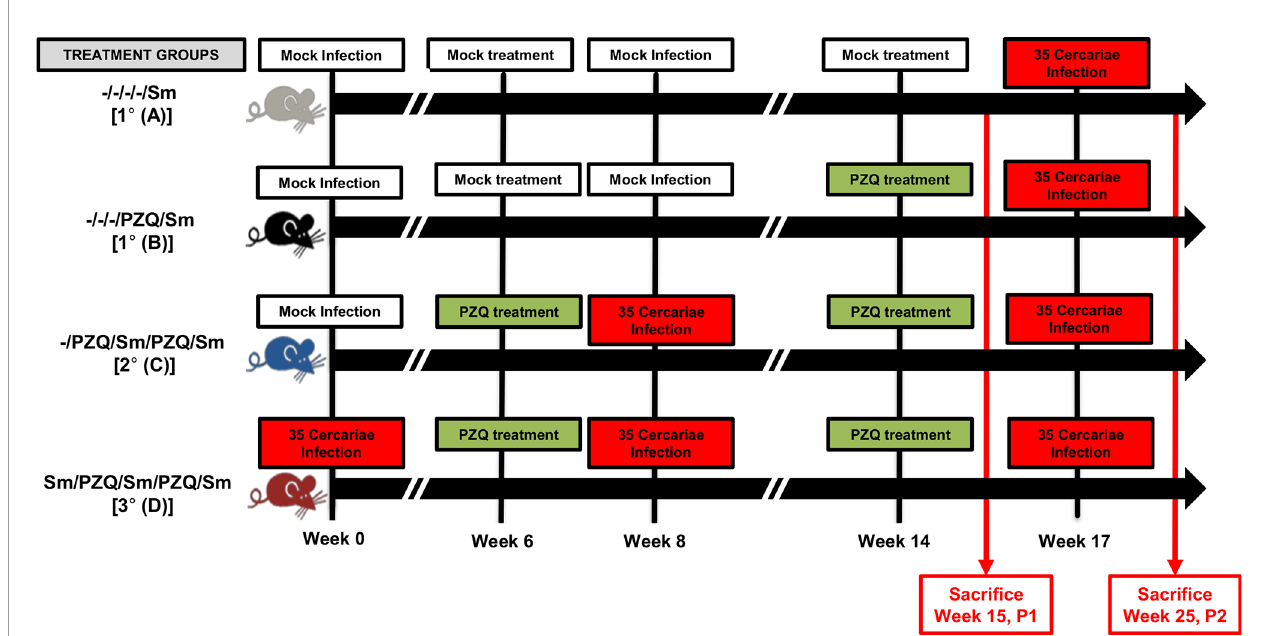
FIGURE 1 | Adjusted study design. Following experimental infection of mice with S. mansoni cercariae and anti-parasitic treatment with racemic Praziquantel (PZQ), the susceptibility to reinfection with S. mansoni and schistosomiasis-driven pathology was assessed. Brie fl y, C57BL/6 wild-type and immunocompetent mice (8-10 weeks old to ensure the use of adult mice only) of 20-30g were separated into four experimental groups omitting long term infections without interspersed episodes of PZQ treatments i.e. groups A, B, C and D. Group A for an overall total of 1 infection and no PZQ treatment i.e. -/-/-/-/Sm, group B with a single pretreatment with PZQ and an overall total of 1 infection i.e. -/-/-/PZQ/Sm; group C for a single pretreatment with PZQ, an overall total of two infections intercalated by another treatment with PZQ i.e. -/PZQ/Sm/PZQ/Sm; group D for an overall total of three infections intercalated by two PZQ treatments i.e. Sm/PZQ/Sm/PZQ/Sm, as indicated on the illustration. Practically, mice were infected percutaneously with 35 S. mansoni cercariae (or cercariae water as Mock) and treated 6 weeks later with racemic PZQ (or carrier solution) by administration at 400mg/kg twice by oral gavage. One week following the end of anti-parasitic treatment with PZQ, mice were reinfected percutaneously with 35 S. mansoni cercariae (or cercariae water as Mock) i.e. at week 8. Animals were then treated with racemic PZQ (or carrier solution) 6 weeks later i.e. at week 14 by daily oral administration of PZQ at 400mg/kg by oral gavage for 7 days. Two weeks after the end of this second round of anti-parasitic treatment i.e. at week 17, all mice, including controls from group A and B, were reinfected percutaneously, with 35 S. mansoni cercariae. Animals were sacri fi ced in part at week 15 p.i. (time point 1 i.e. P1) or week 25 (time point 2, i.e. P2) for assessment of parasitological, immunological and pathological changes between groups. Speci fi cally, biopsies of spleen, liver and blood were done for laboratory analyses of egg burdens, Antibody ELISA, Cytokine ELISA, Histology and Flow cytometry. Two independent experiments were conducted with 4-5 mice per group to be sacri fi ced at P1 (Group A &B, 4 mice; Group C, 5 mice; Group D, 4 mice) and 5-7 mice per group to be sacri fi ced at P2 (Group A, 5 mice; Group B, 4 mice; Group C, 6 mice; Group D, 7 mice). A total of 70 mice were used for this